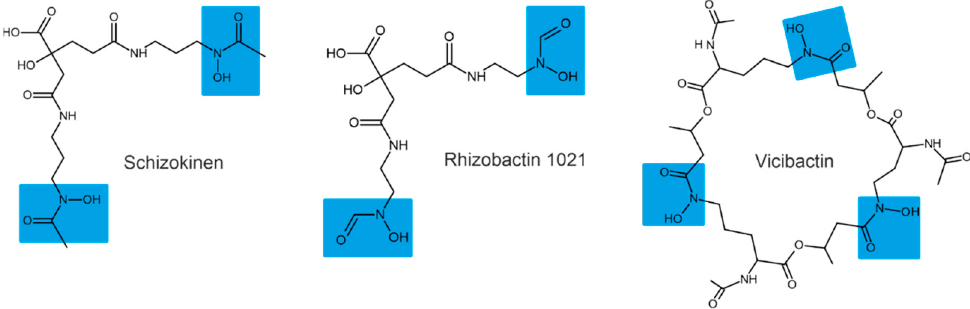
Figure 1. Examples of hydroxamate siderophores: shizokinen, rhizobactin, vicibactin. Hydroxamate functional groups are highlighted in blue.